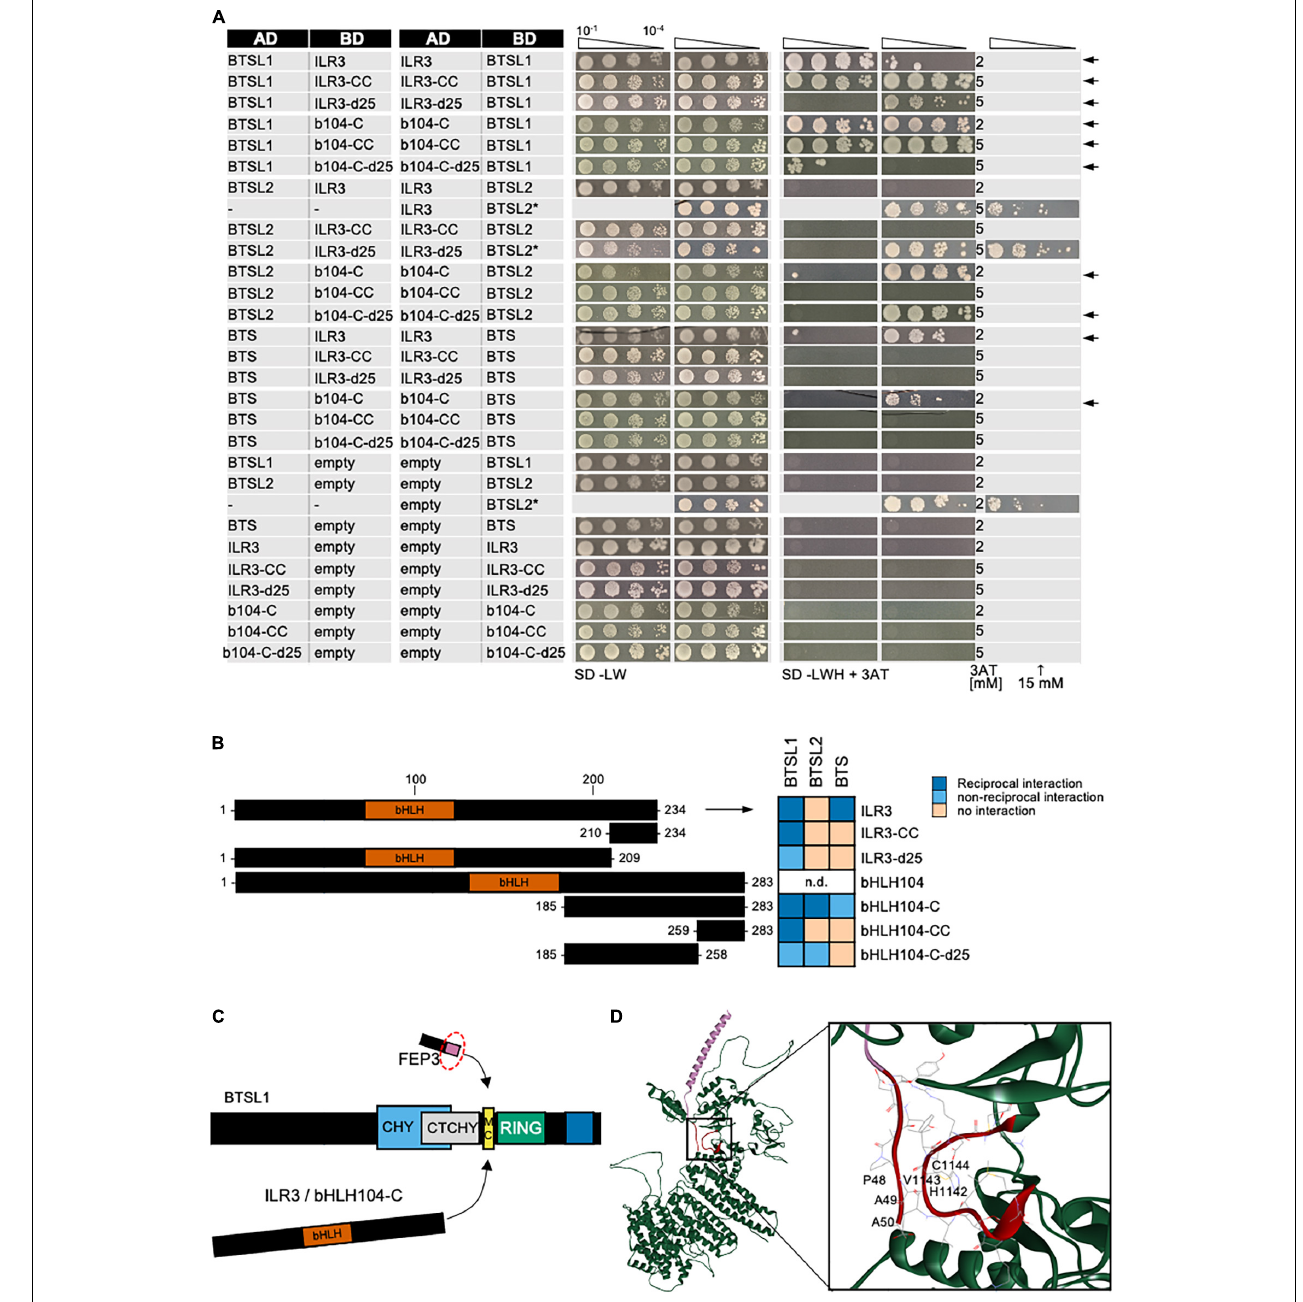
FIGURE 6 | Mapping of the interaction site in bHLH subgroup IVc proteins ILR3 and bHLH104 by yeast two hybrid (Y2H) assays. (A) Targeted deletion forms of bHLH proteins were tested in reciprocal targeted Y2H assays against BTSL1. Yeast co-transformed with the AD and BD combinations were spotted in 10-fold dilution series (A 600 = 10 − 1 –10 − 4 ) on SD-LW (transformation control) and SD-LWH plates supplemented with different 3AT concentrations (conc.) as indicated (selection for protein interaction). Negative controls: empty vectors. Arrows indicate interaction. BTSL2* and BTSL2 refer to two separate controls. (B) Schematic representation and summary of Y2H results. Left, schematic representation of bHLH and deletion constructs, used for Y2H. The color illustrates the proposed region of similarity with the C-terminus of FEP3/IMA1 (see Supplementary Figure 8 ). Right, summary results of panel (A) . The color code distinguishes reciprocal positive interactions (dark blue), non-reciprocal positive interactions (light blue), negative results on interactions (light orange). (C) Proposed mechanistic model of BTSL1-C interaction at the fine-mapped M-C site with bHLH proteins of subgroup IVb and IVc and the C-terminal conserved region of FEP3/IMA1. Compare with Figures 4–6 for depicted functional domains. (D) Molecular homology modeling and molecular docking of BTSL1 and FEP3/IMA1. Left, Homology model of BTSL1 protein predicted using AlphaFold2, used for molecular docking with FEP3. Right, details of molecular docking model between BTSL1 and FEP3. The aa highlighted are HVC within the M-C region of BTSL1 and the PAA region at the C-terminus of FEP3 that shows similarity with the C-terminus of bHLH IVb and IVc proteins. The model suggests that FEP3 is an allosteric inhibitor of bHLH binding to BTSL1.